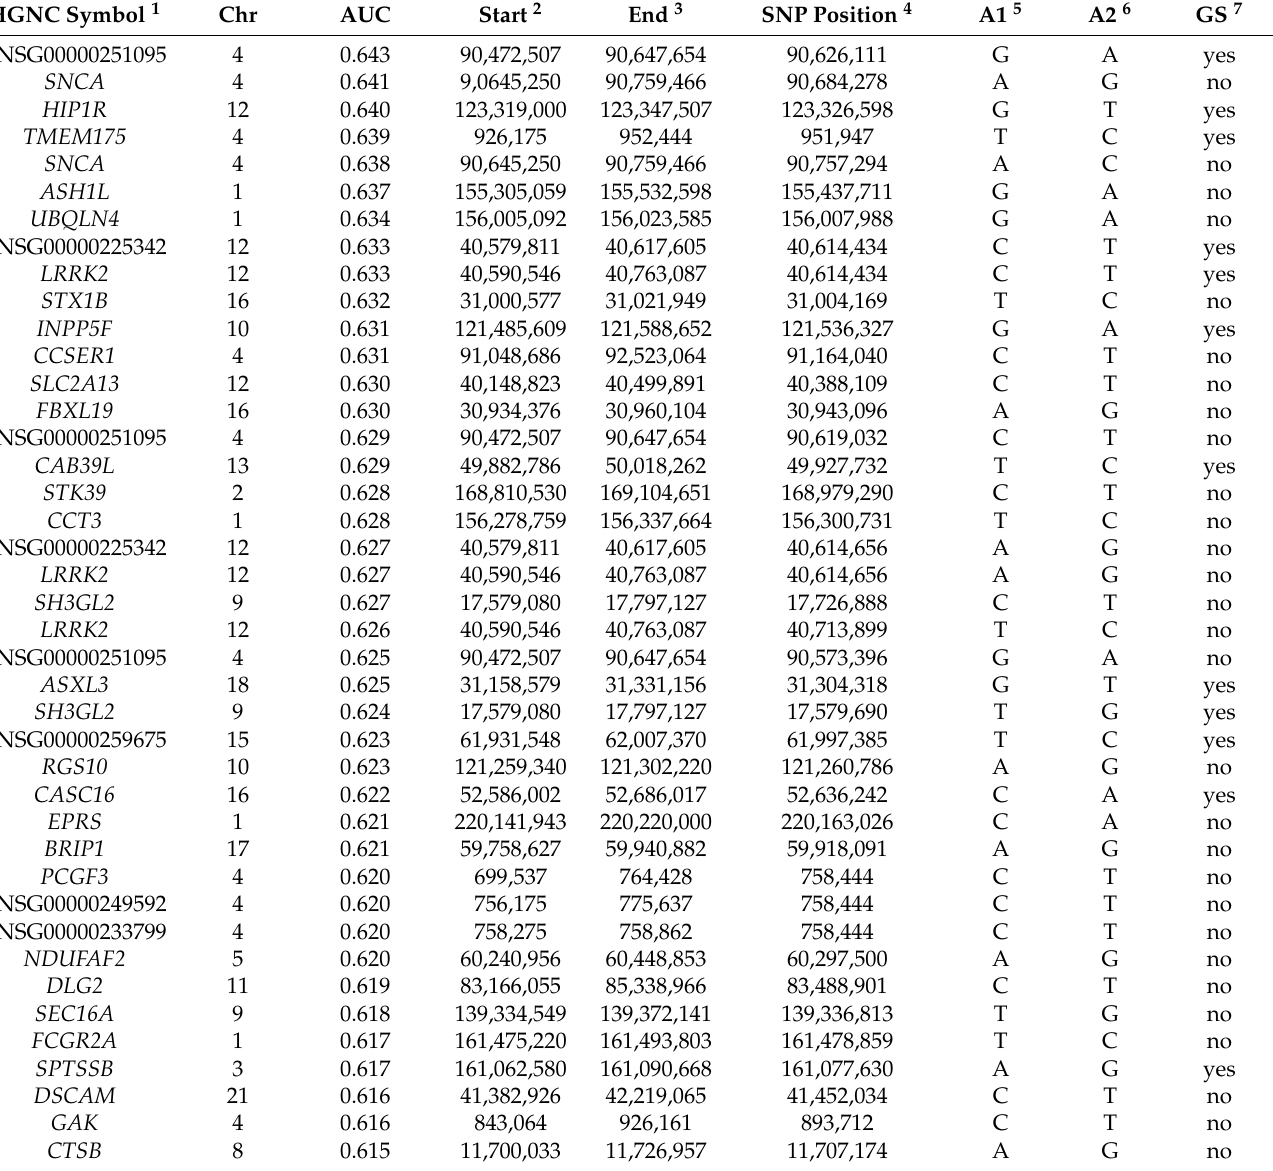
Table A4. Most relevant SNPs located within